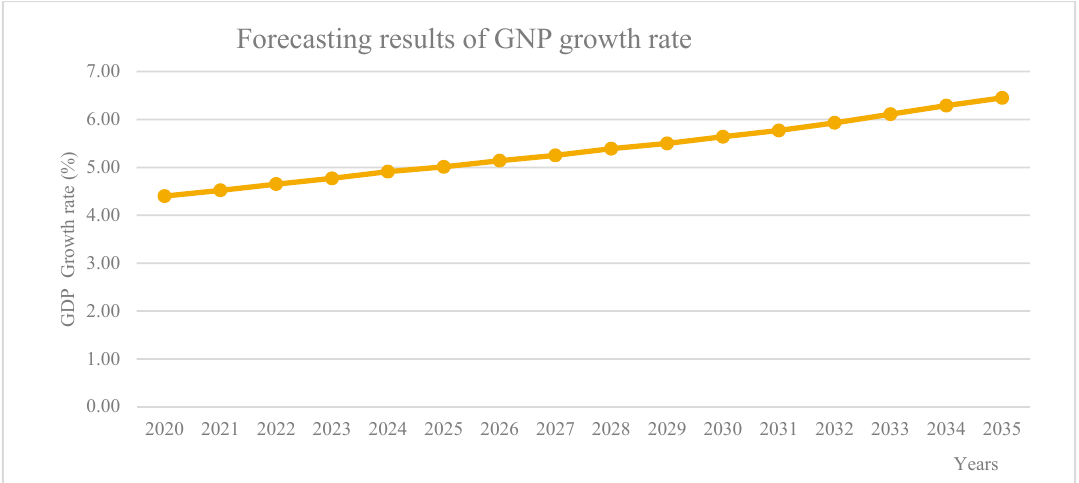
Figure 7. The forecasting results for GNP from 2020 to 2035 in Thailand .